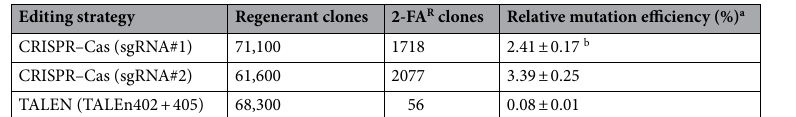
Figure 1. CRISPR–Cas and TALEN targeted editing on the APT gene. ( a ) Structure of the APT gene and sgRNAs and TALEN positions. Boxes in white represent the exons and black lines represent the introns. Black arrows represent the primers used for PCR and sequencing. ( b ) Target sequences for sgRNA#1 and sgRNA#2 on the APT gene and sequence of CRISPR–Cas mutants. PAM (protospacer adjacent motif) sequence is in bold, green letters plus arrow indicate the sequences targeted by sgRNA1 and sgRNA2. ( c ) Target sequences for TALEN402-TALEN405 on the APT gene. Blue and purple letters plus arrows indicate the sequences targeted by TALEN402 and TALEN405 respectively, in red target sequence for the FOK1 nuclease dimer. DNA insertions are shown in orange and deletions with dashes. In the blue frames, the microhomologies potentially involved in Alt-EJ-mediated repair of the induced DSBs.